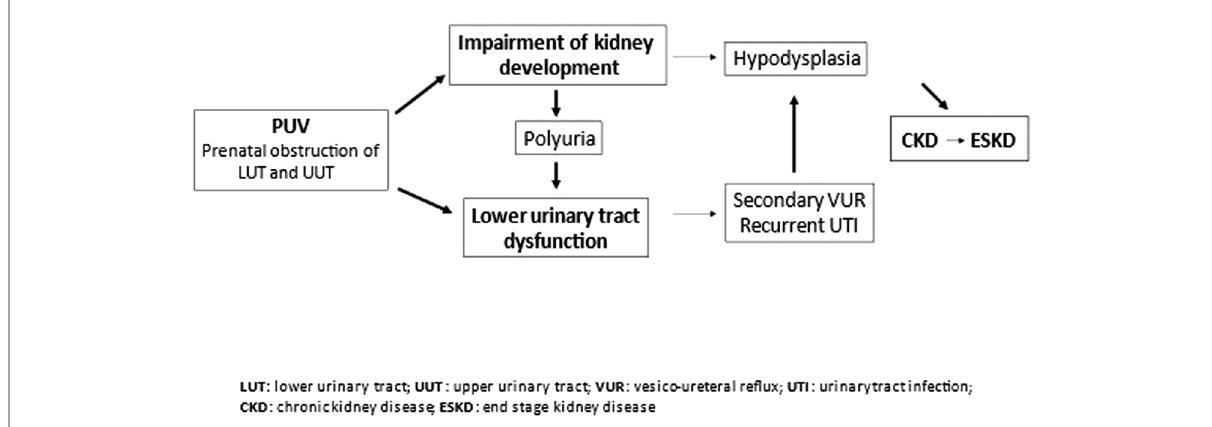
FIGURE 3 Pathophysiology of chronic kidney disease in posterior urethral valves. Posterior urethral valves (PUV) lead to obstructions of the urinary tract, with consequent impairment of kidney and bladder function development. Impairment in kidney development may result in hypodysplasia with a reduced nephron mass, and chronic kidney disease. Chronic kidney disease can progress to end-stage kidney disease. Lower urinary tract dysfunctionn can be aggravated by polyuria of the impaired kidneys and cause secondary vesicoureteral re fl ux and recurrent urinary tract infections. The latter may cause parenchymal scars in the hypodysplastic kidneys and accelerate renal failure